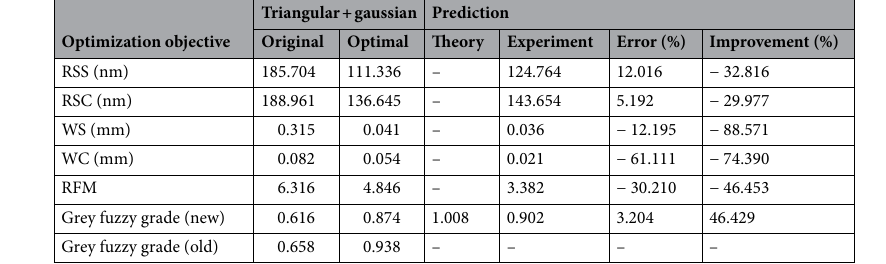
Table 18. Comparison of the original scheme, the optimal scheme and the prediction scheme.